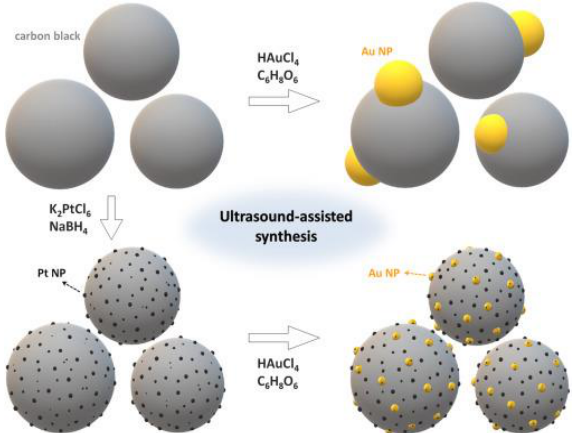
Figure 9. Schematic illustrations of the synthesis procedures of Pt/C, Pt-Au/C and Au/C structures. Reproduced from [121], with permission from Elsevier, 2018.